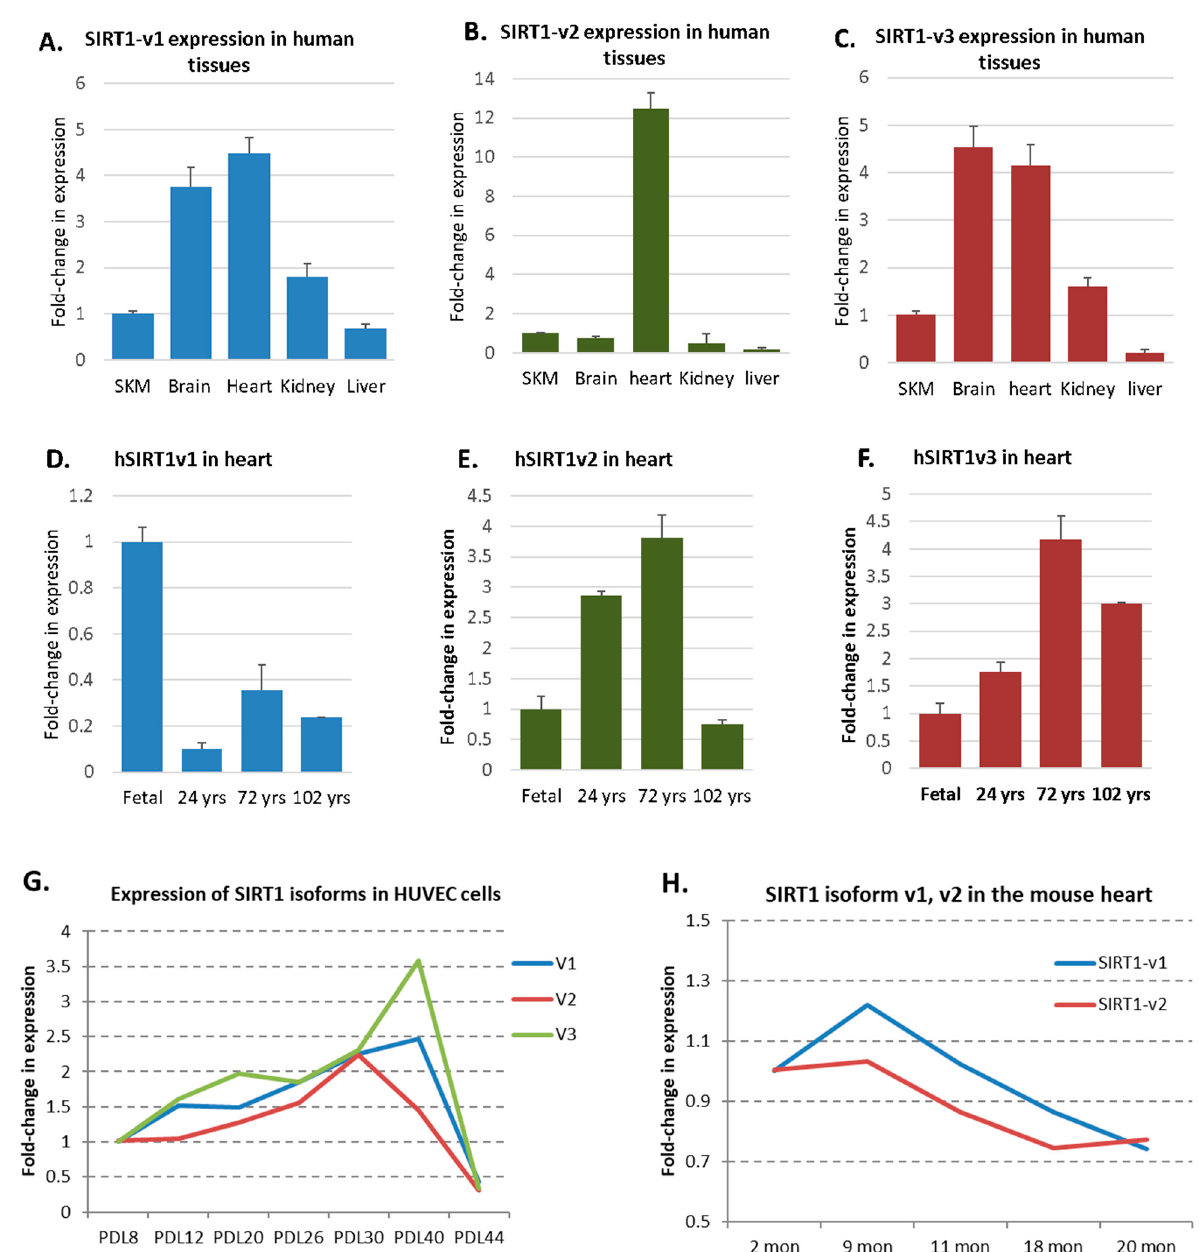
Figure 5. SIRT1 isoform expression in human and mouse hearts. ( A – C ). SIRT1-v1, v2, and v3 expression in human skeletal muscle (SKM), brain, heart, kidney and liver. ( D – F ). SIRT1-v1, v2 and v3 expression in human hearts of fetus, young adult, old and very old individuals. ( G ). SIRT1-v1, v2, and v3 expression in HUVEC cells at various multiple population doubling levels. ( H ). SIRT1-v1 and v2 expression in the mouse hearts from two months to 20 months of age.